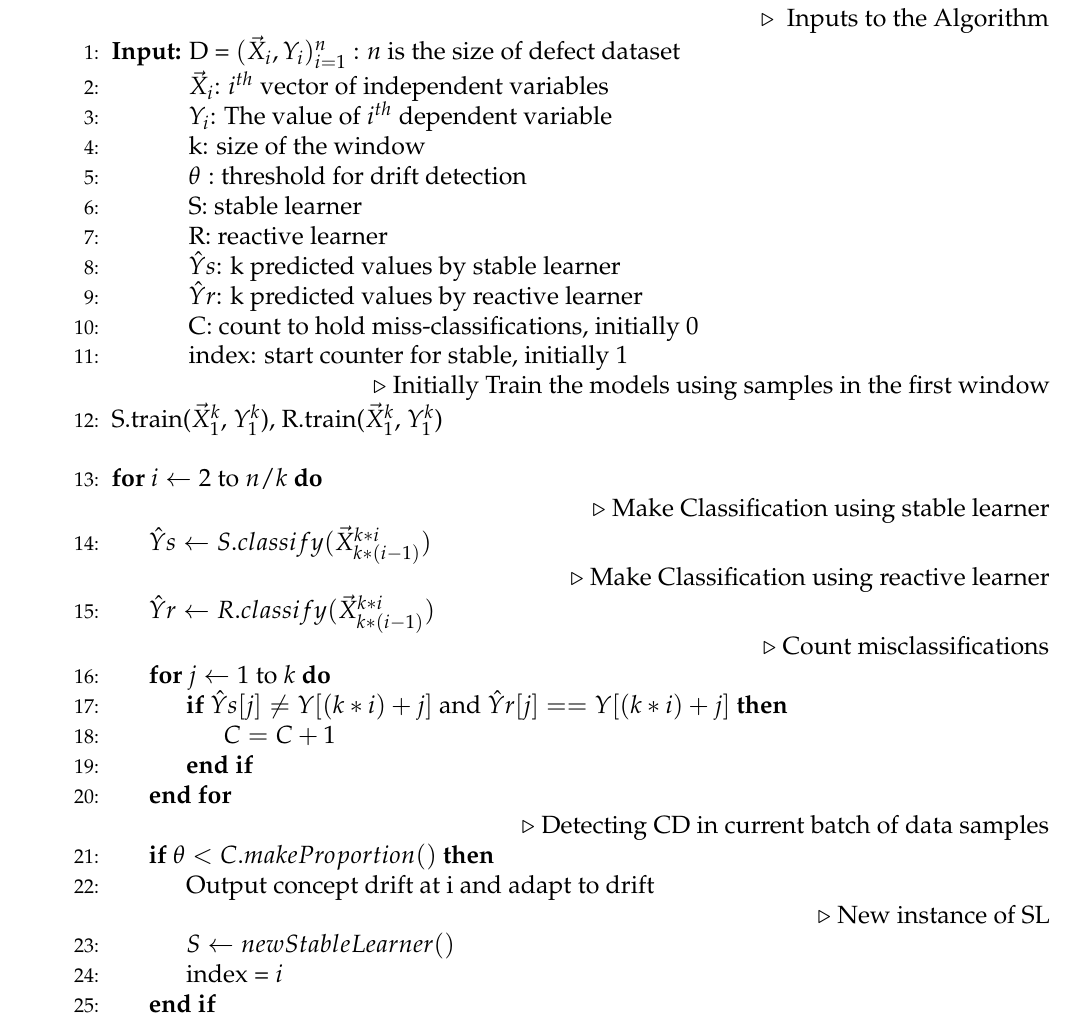
Algorithm 1 PL-based approach for CD detection and adaptation in